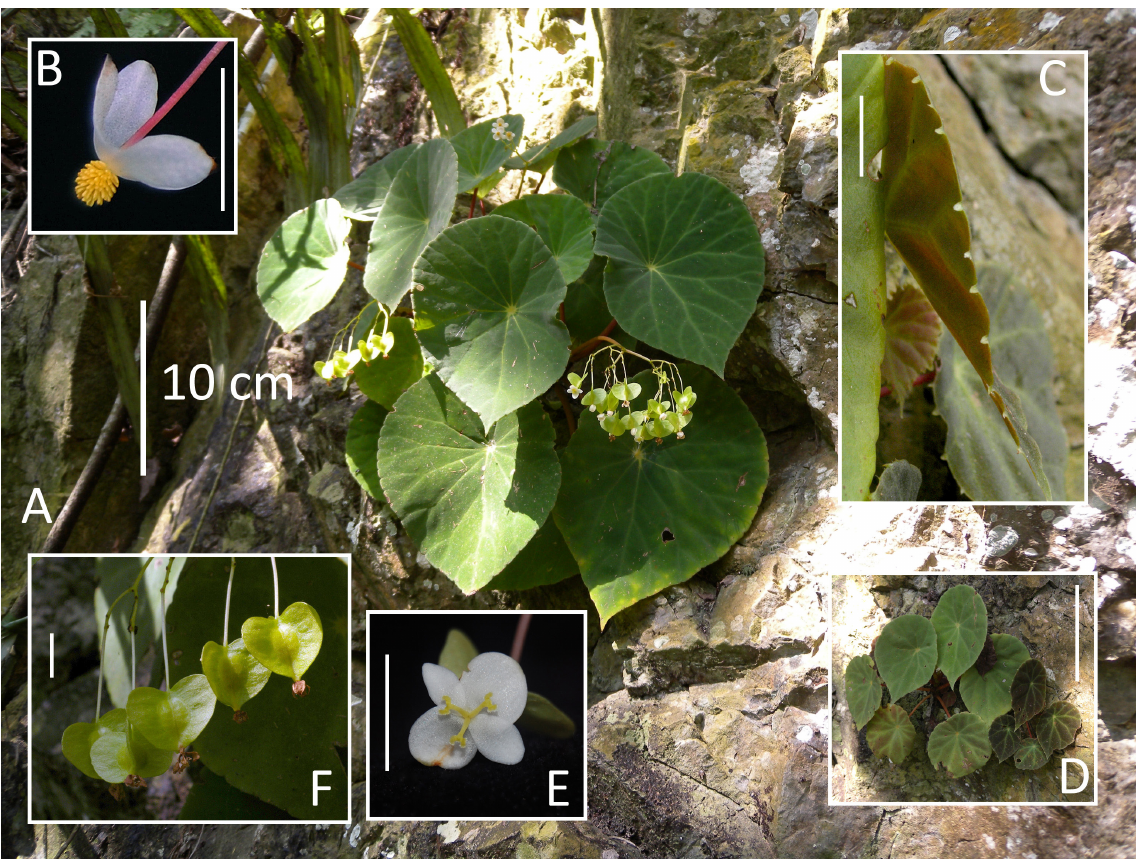
Fig. 11. Begonia kudoensis Girm. sp. nov. A . Habit (Gunung Batu Kudo, type collection Puglisi et al. CP67 ). B . Male flower, from cultivated plant in Bali Botanic Garden derived from CP67 . C . Leaf lamina edge showing recurved teeth. D . Whole plants showing different colour forms. E . Female flower from cultivated plant in Bali Botanic Garden derived from CP67 . F . Fruit on a pendulous pedicel (type collection Puglisi et al. CP67 ). C & D taken at the type locality. Scale bars on insets: B, C, E, F = 1 cm; D = 5